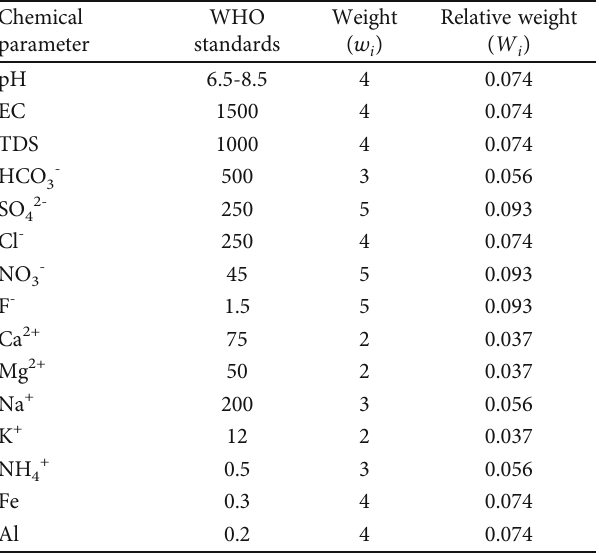
Table 2: Relative weights of groundwater quality parameters studied and reference standards.